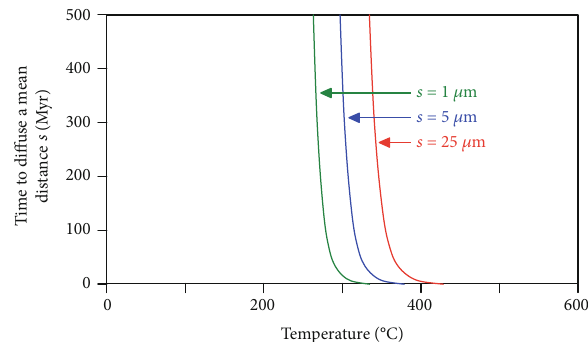
Figure 2: Time ( t in Myr) to di ff use oxygen a distance s of 5, 10, and 20 μ m in quartz as a function of temperature based on di ff usion data of Farver and Yund [47].